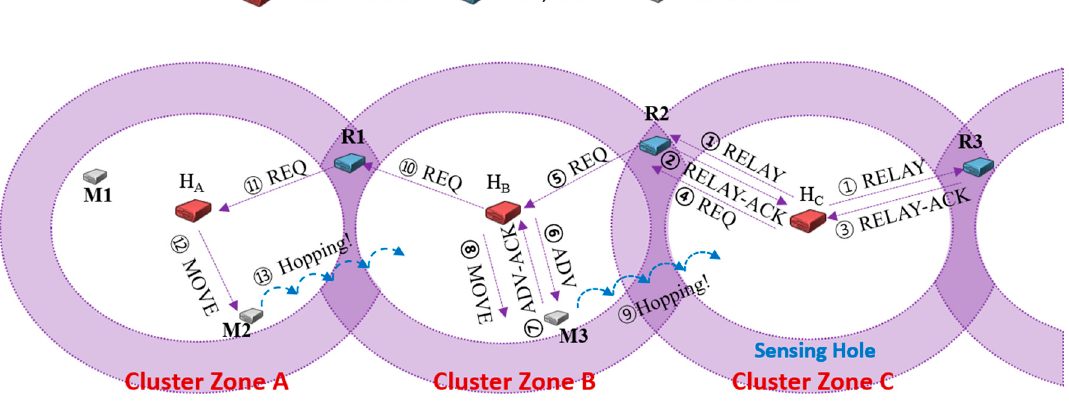
Figure 2. An example of hopping sensors relocation [25].